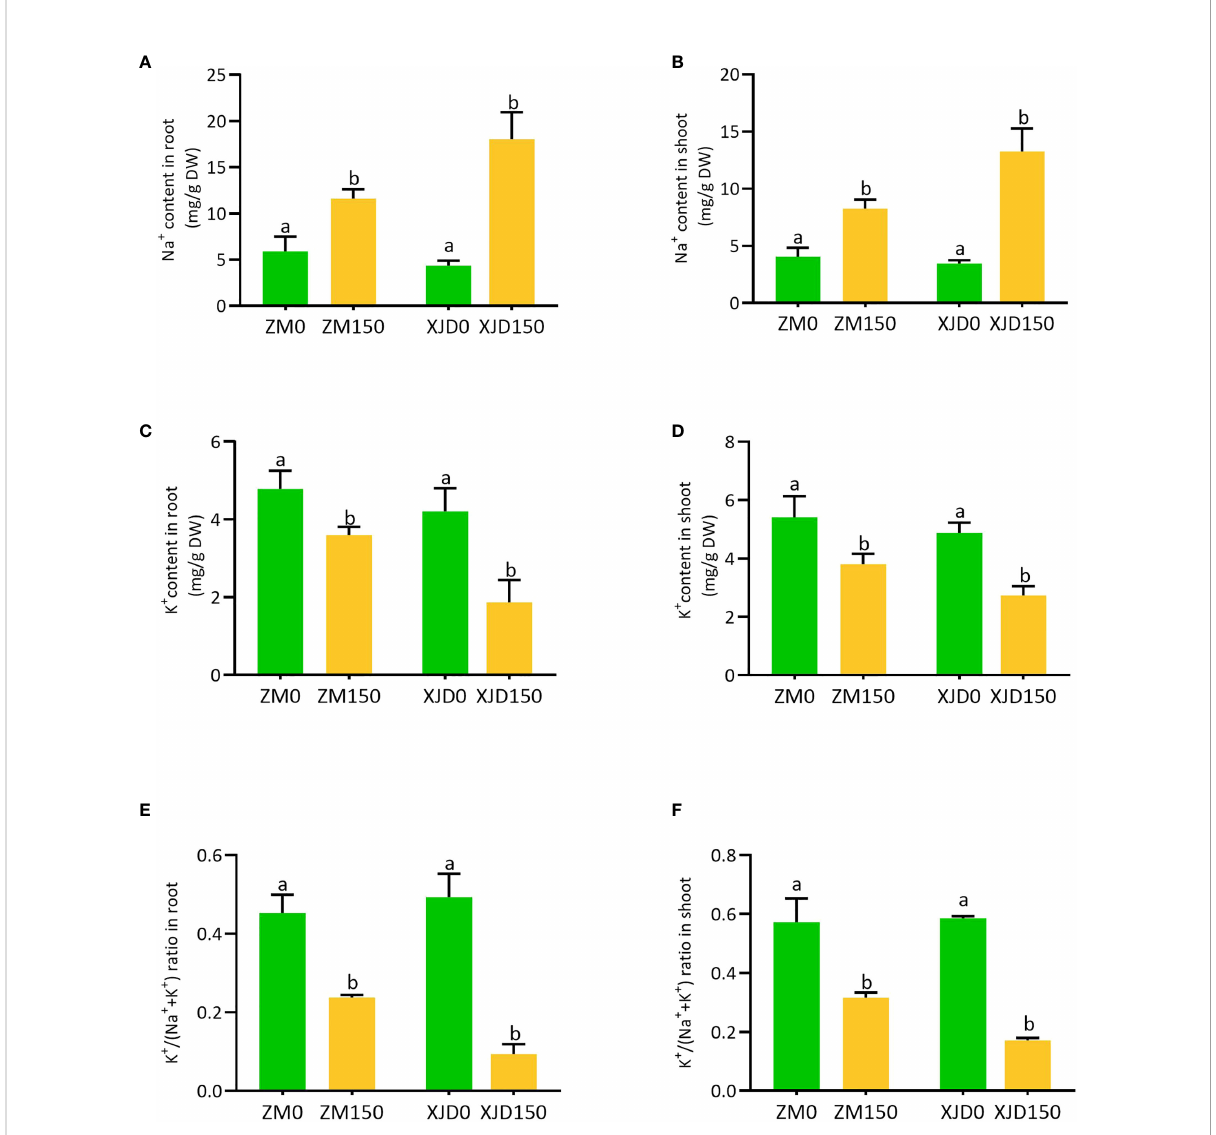
FIGURE 3 Elemental concentration in two contrasting alfalfa under salt stress. The Na + in roots (A) , Na + in shoots (B) , K + in roots (C) , K + in shoots (D) , K + / (Na + + K + ) ratio in roots (E) , and K + /(Na + + K + ) ratio in shoots (F) , in Zhongmu (ZM) and Xingjiang Daye (XJD) under salt stress. The numeric zero (0) indicates salt-untreated (control) plant, while the numeric 150 indicates 150 mM salt treatment. Different letters above the column bar indicate signi fi cant differences among the means ± SD of treatments (n = 3). Data were analyzed by ANOVA and Tukey ’ s tests at p ≤ 0.05 signi fi cant